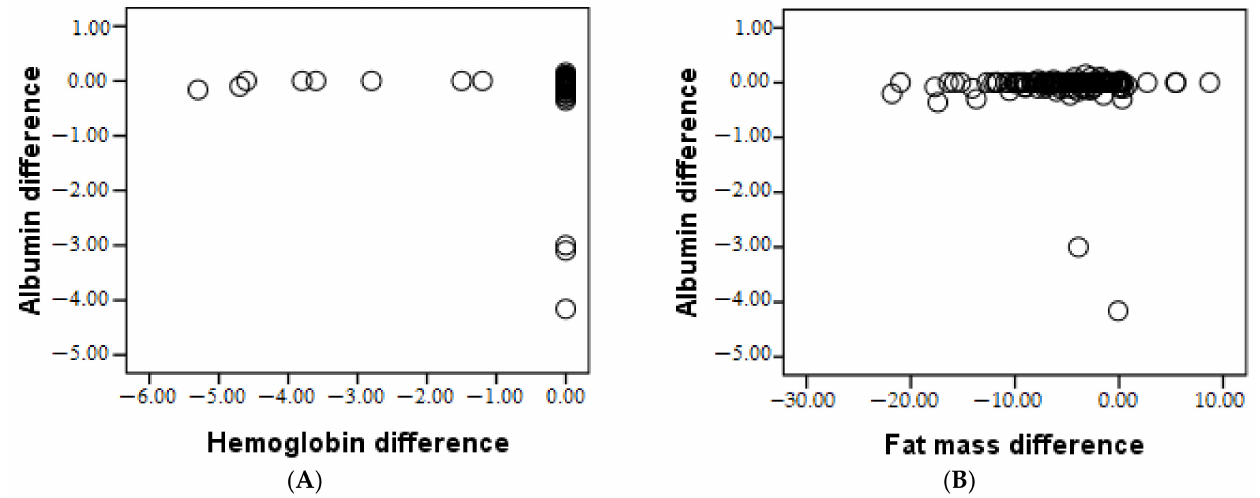
Figure 1. The correlation between albumin and hemoglobin ( A ), and fat mass ( B ),